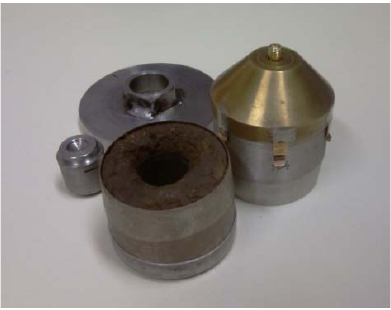
Figure 3. The proposed sensor (on the right) and its